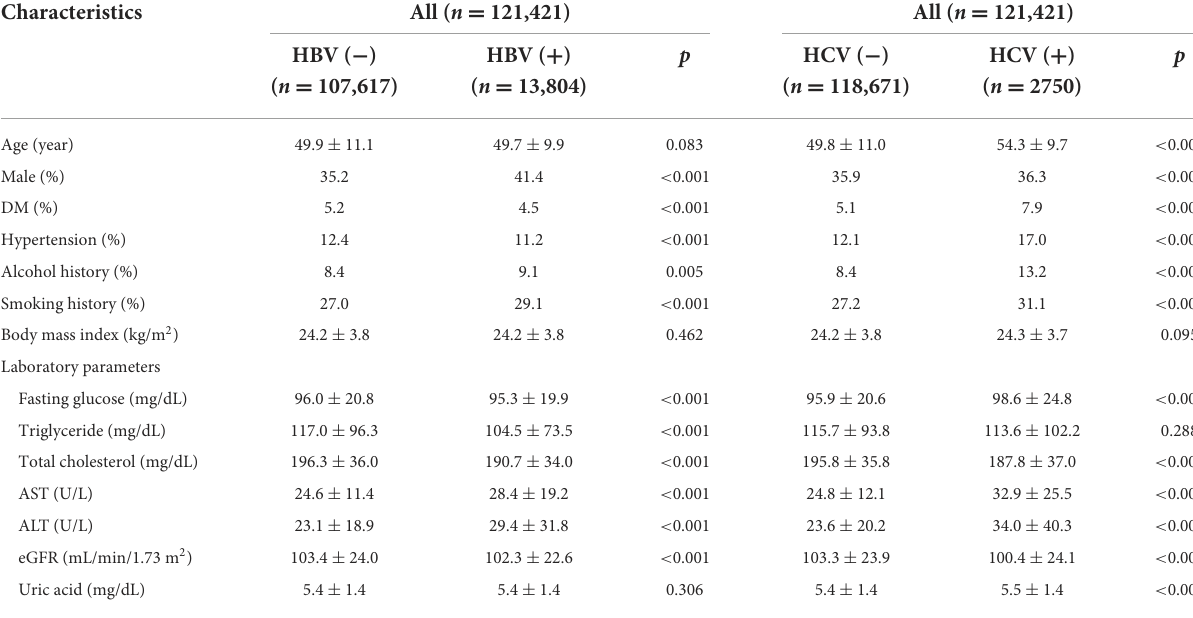
TABLE 1 Clinical characteristics of the study participants classified by the presence of HBV or HCV infections.